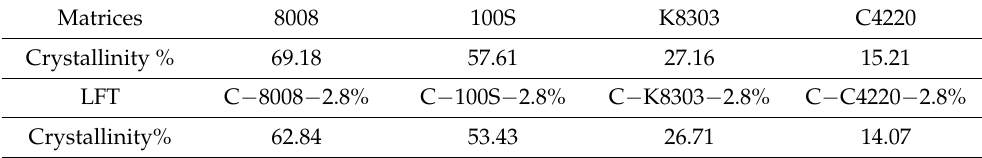
Table 3. The crystallinities of the neat matrices and the corresponding LFT composites.